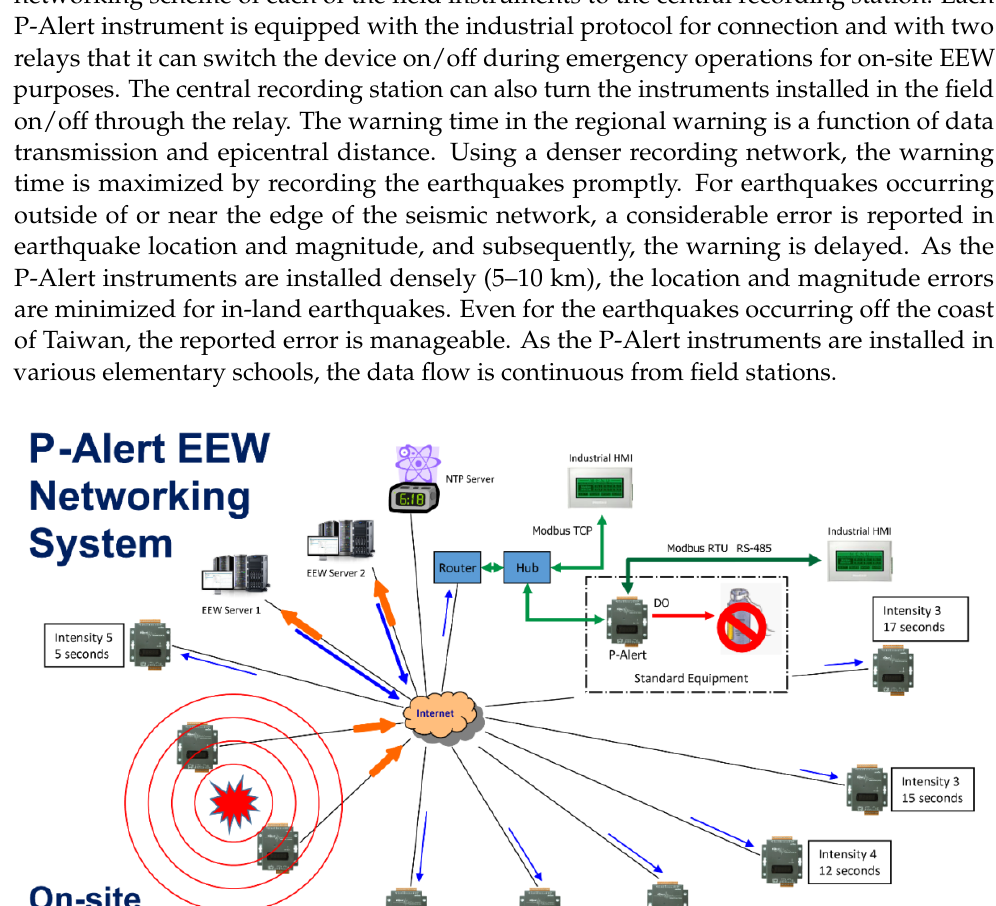
Figure 4. The concept of the P-Alert networking system. Each P-Alert is equipped with the industrial protocol for connection and with two relays that can turn the device on/off for emergency operation. The central station also can turn remote devices on/off through P-Alert relays.